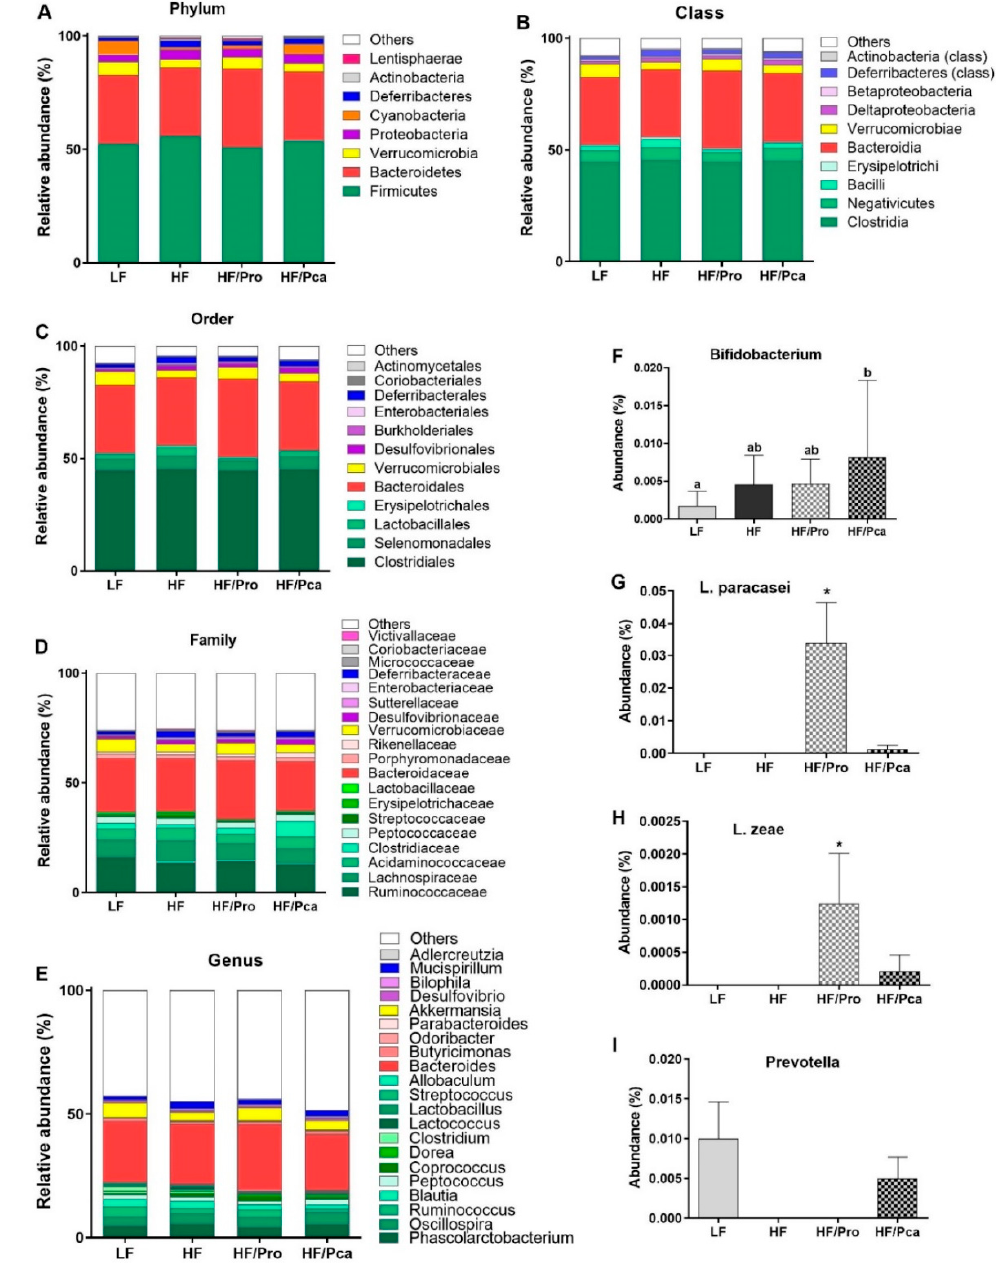
Figure 3. Non-encapsulated or encapsulated probiotic supplementation led to compositional changes in gut microbiota. Microbial composition at the phylum ( A ), class ( B ), order ( C ), family ( D ) genus I, and species ( F – I ) of rats fed an LF, HF, HF/Pro, or HF/Pca diet for seven weeks. n = 8/group. Asterisk (*) or a,b,c means with different letters are statistically significant, p < 0.05. All phylogenic levels present with abundance >1% are represented. HF, high fat; HF/Pca, HF with supplemented with encapsulated L. casei W8 (4 × 10 7 cfu/g diet); HF/Pro, HF supplemented with non-encapsulated L. casei W8 (4 × 10 7 cfu/g diet); LF, low fat.